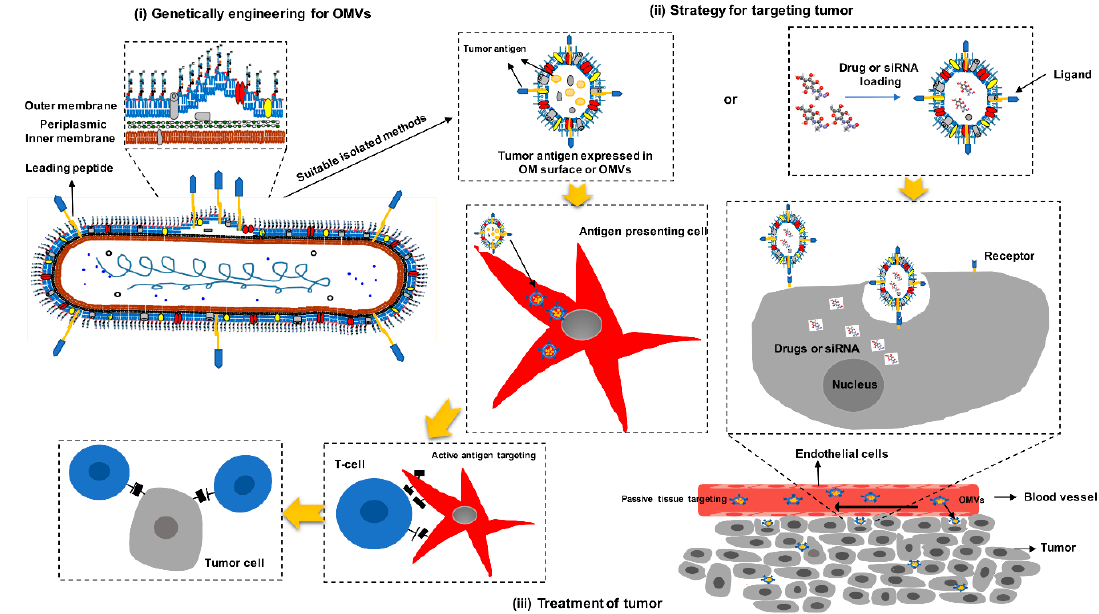
Figure 2. Schematic representation of mechanisms by which OMVs act as carriers to deliver tumor antigens in cancer therapy. Tumor antigens are targeted to the membrane by the leading peptide. OMVs are released from mutant bacterial cells and carry tumor antigens. OMVs travel via blood vessels to arrive at the target tissue. Cells mainly recognize OMVs by ligand-receptor interaction and internalize OMVs by membrane invagination or membrane fusion.